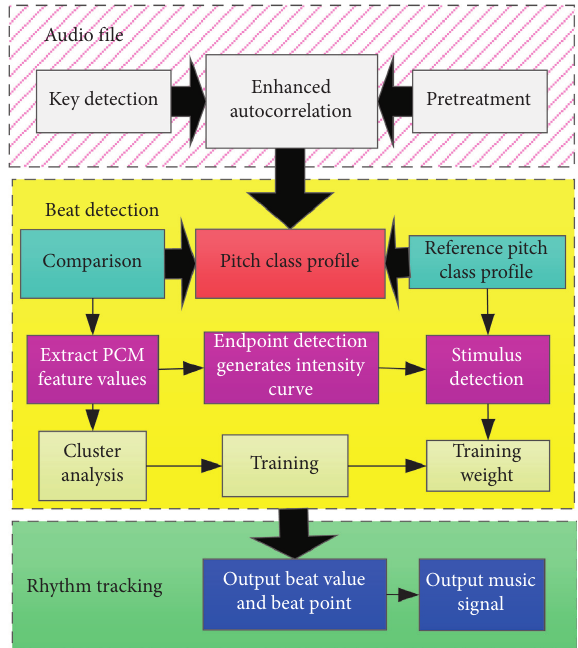
Figure 2: The flow of the beat tracking